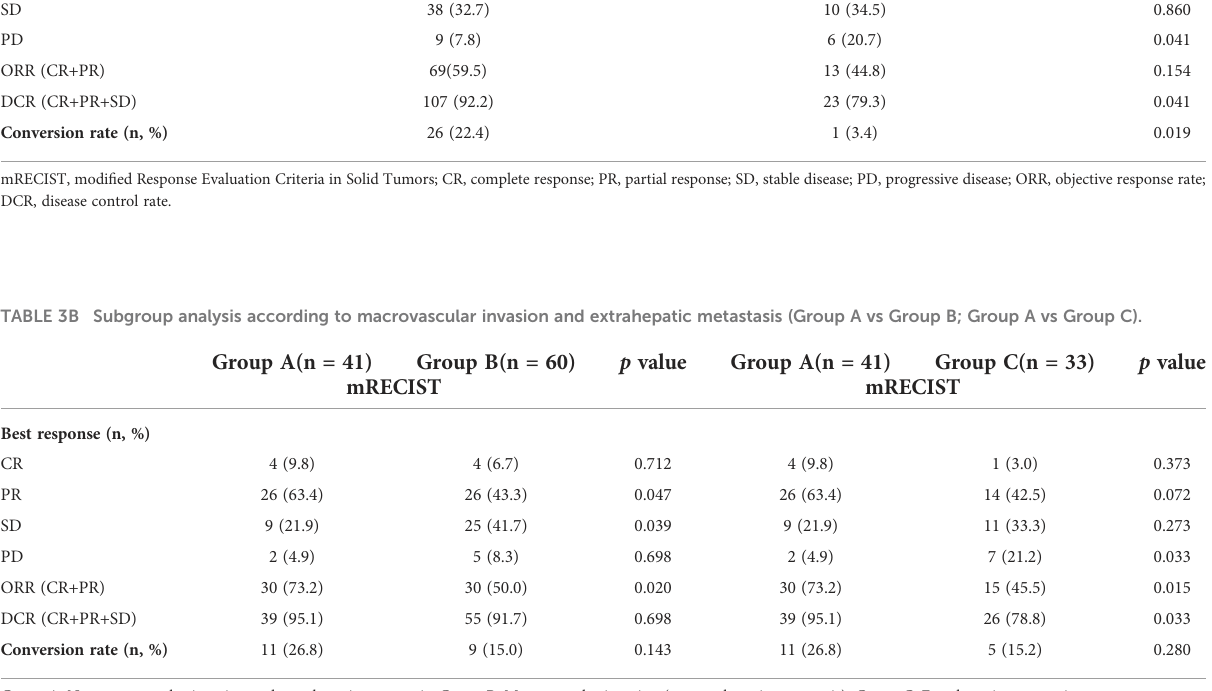
Group A: No macrovascular invasion and extrahepatic metastasis; Group B: Macrovascular invasion (no extrahepatic metastasis); Group C: Extrahepatic metastasis. mRECIST, modi fi ed Response Evaluation Criteria in Solid Tumors; CR, complete response;PR, partial response; SD, stable disease; PD, progressive disease; ORR, objective response rate; DCR, disease control